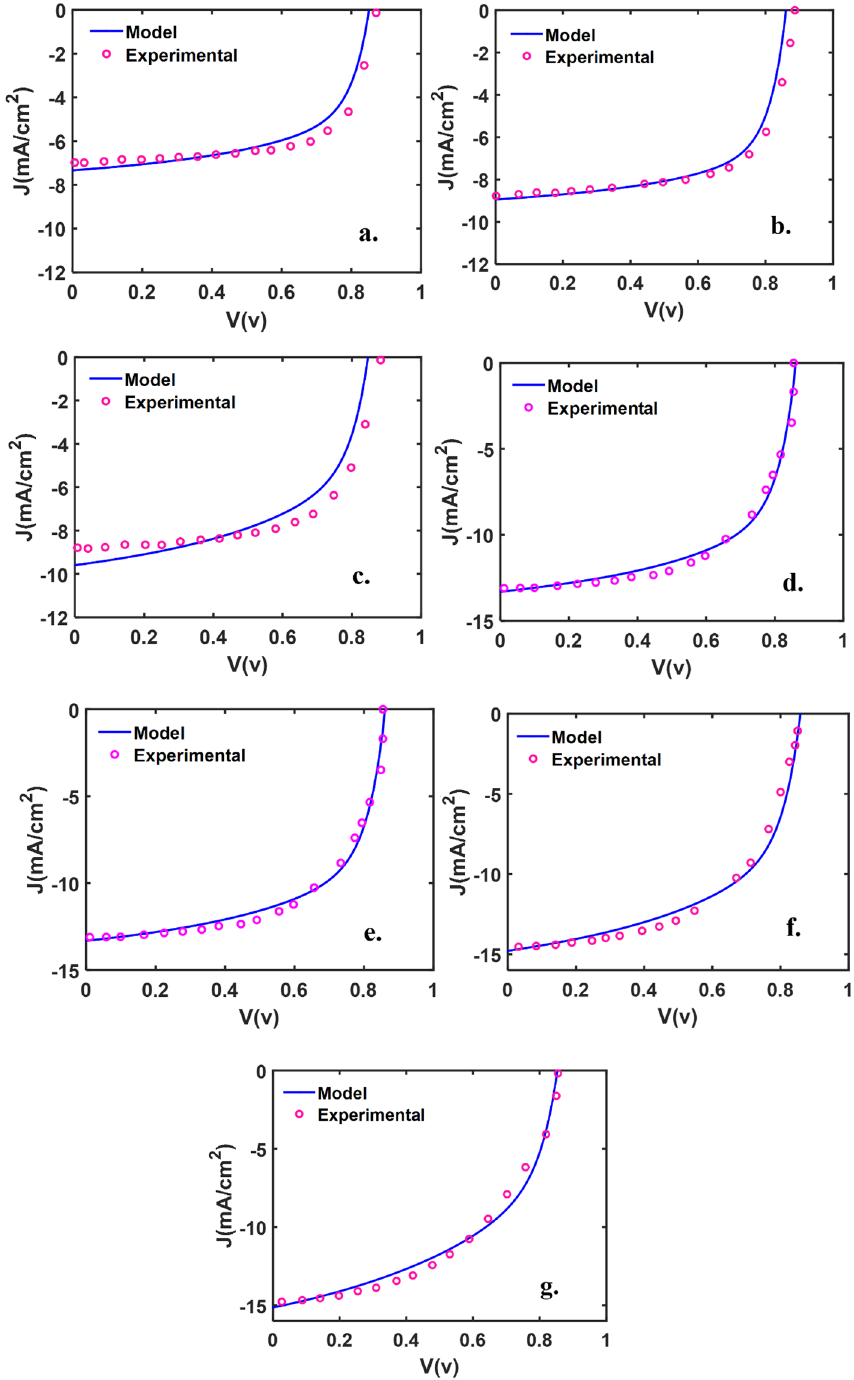
Figure 2. The J-V characteristics of the device with the structure of ITO/ ZnO/ PBDB-T: ITIC/ MoO3/ Ag/ MoO3, with D/M/D thickness of 6 nm/10 nm/40 nm, and PBDB-T: ITIC active layer thickness is: ( a ) 53, ( b )